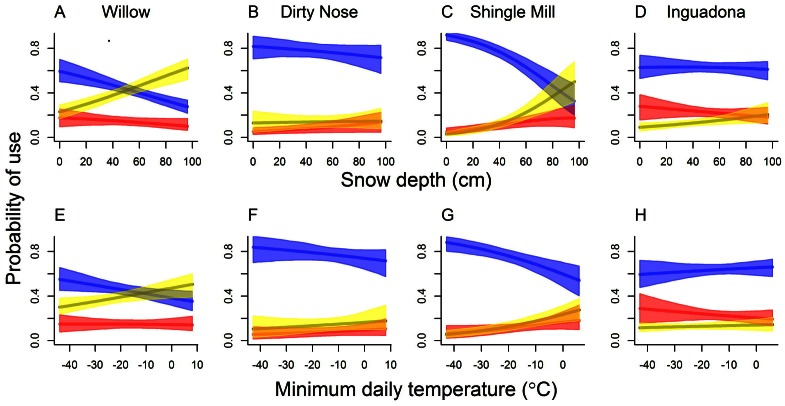
Date-time plots illustrating individual variability in use of dense (≥70% canopy closure), moderately dense (40% ≤×<70% canopy closure), and open conifer cover (<40% canopy closure), and open non-conifer types (openings and hardwood types) by adult (≥1.5 years old), female white-tailed deer monitored using Global Positioning System (GPS) collars collecting locations hourly or every four hours on four study sites, north-central Minnesota, 23 January–14 April 2001, 2002, 2004, and 2005.The solid black line represents average weekly snow depths.